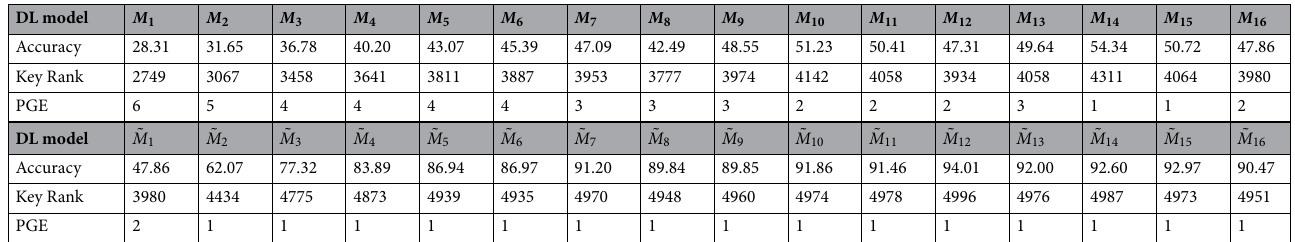
˜ M i on the testing set S 1